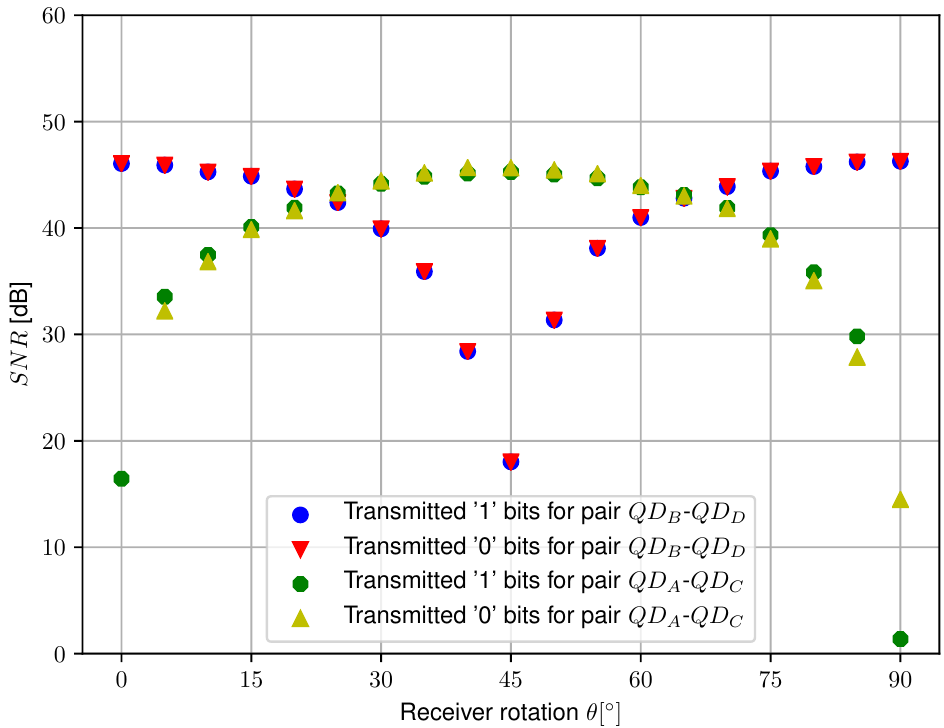
Figure 13. Measured SNR as a function of receiver rotation θ at h = 1.35m for setup